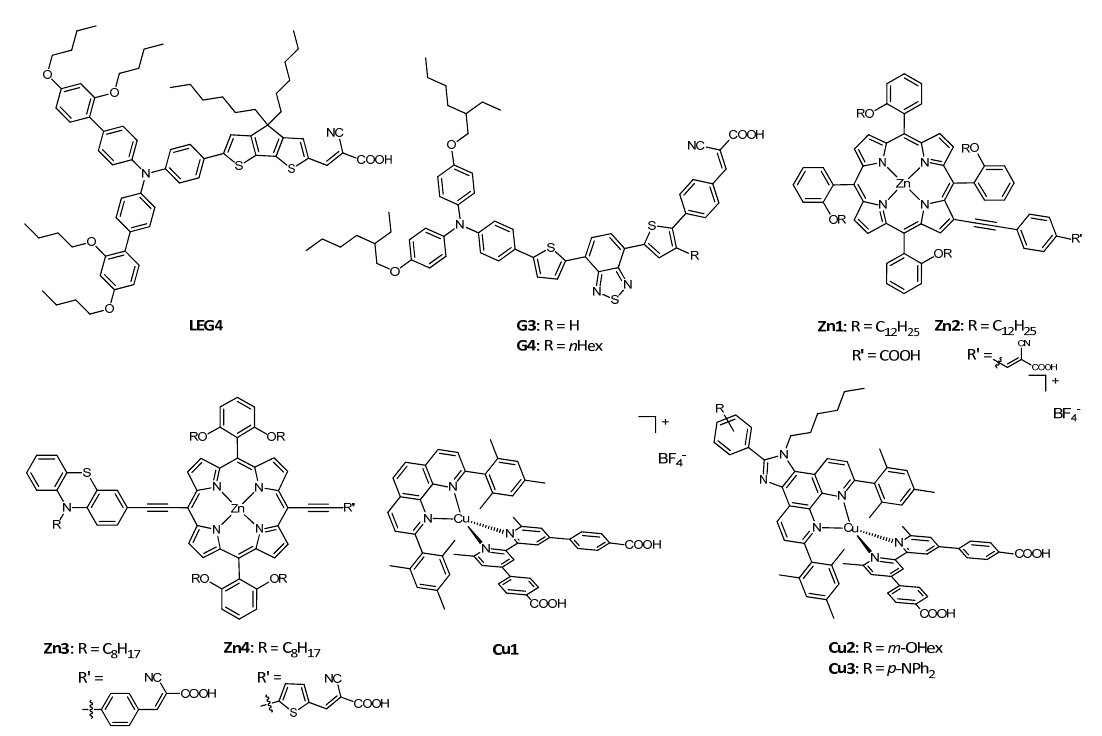
Figure 3. Structure of the dyes used with phenanthroline copper redox mediators.